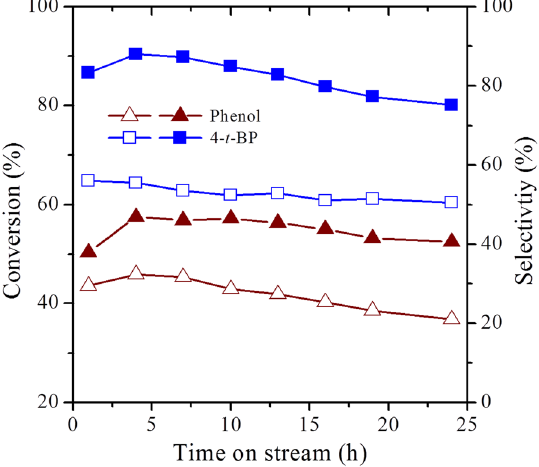
Figure 15. TOS studies of zeolites for tertiary butylation of phenol. Filled symbols: ZH-Y; Open symbols: